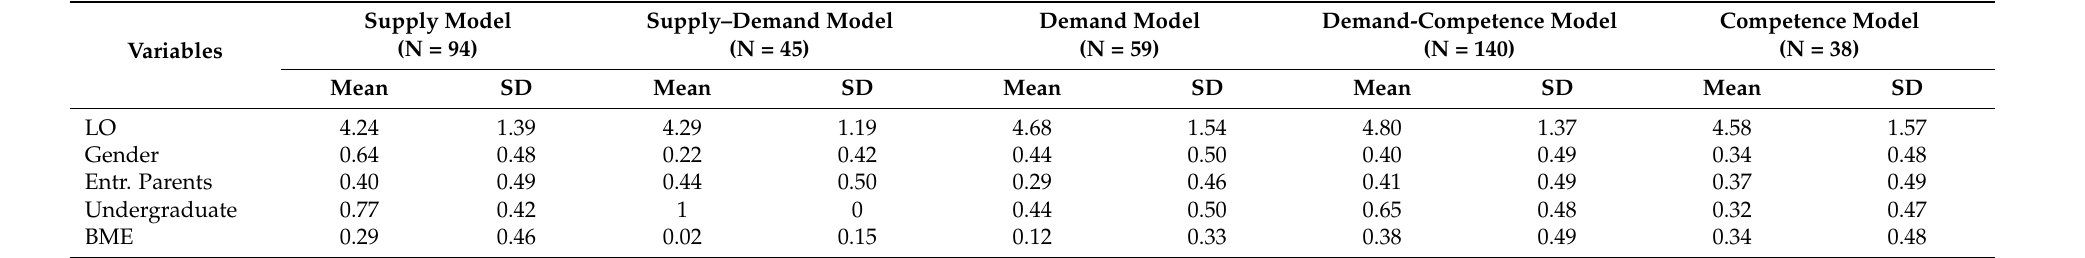
Table 8. Descriptive statistics for the sample divided based on teaching